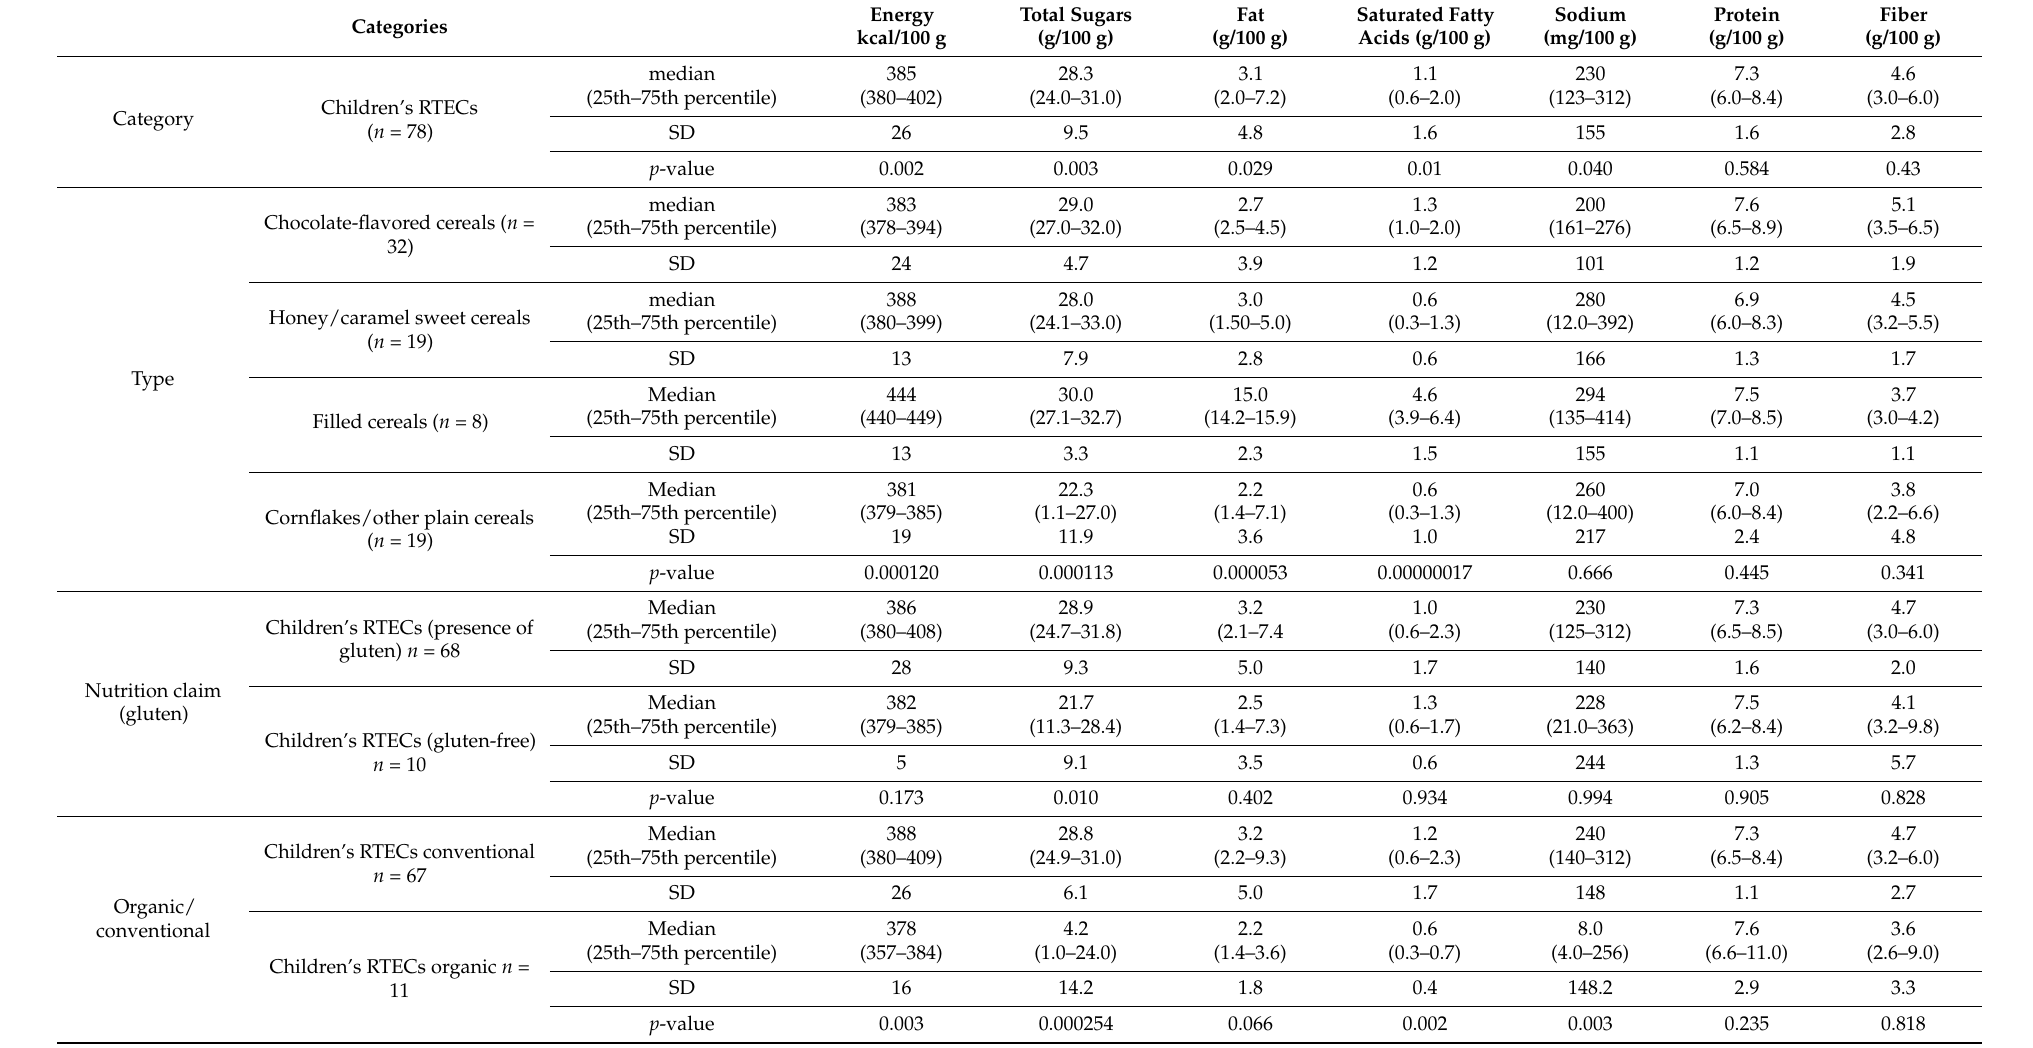
Table 2. Energy, macronutrients, and sodium across the different children RTECs categories considered in the